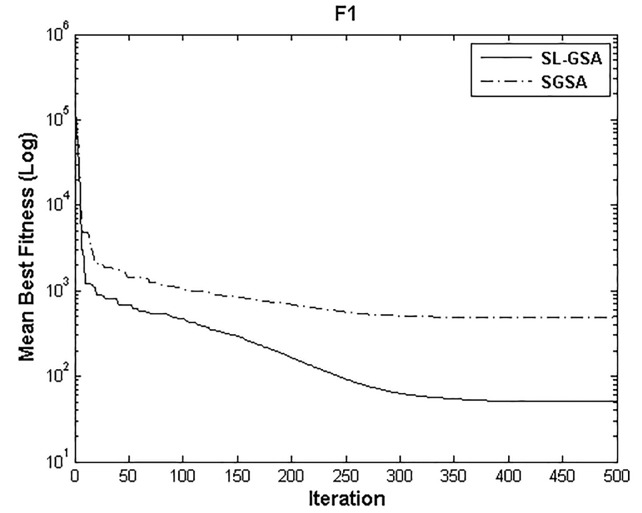
Performance comparison of SGSA and SL-GSA for minimization of F1.